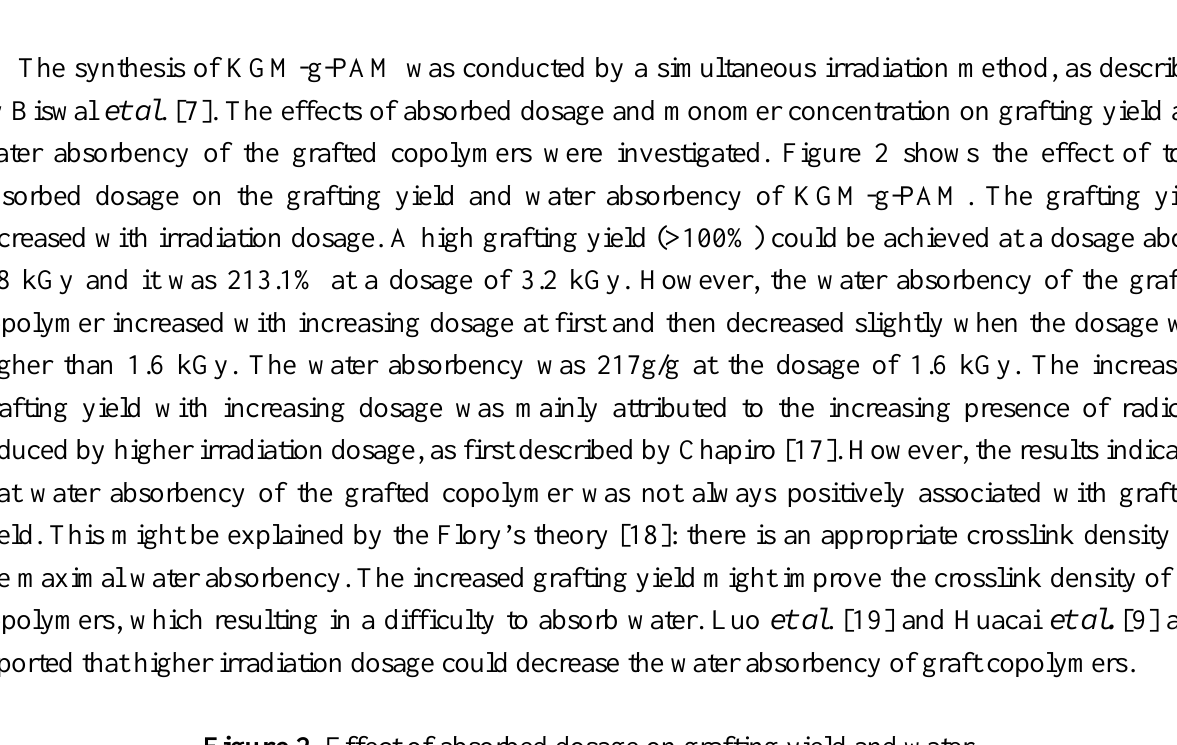
Figure 2. Effect of absorbed dosage on grafting yield and water absorbency of KGM-g-PAM (grafting condition: [KGM] = 0.6%, [AM] = 0.3